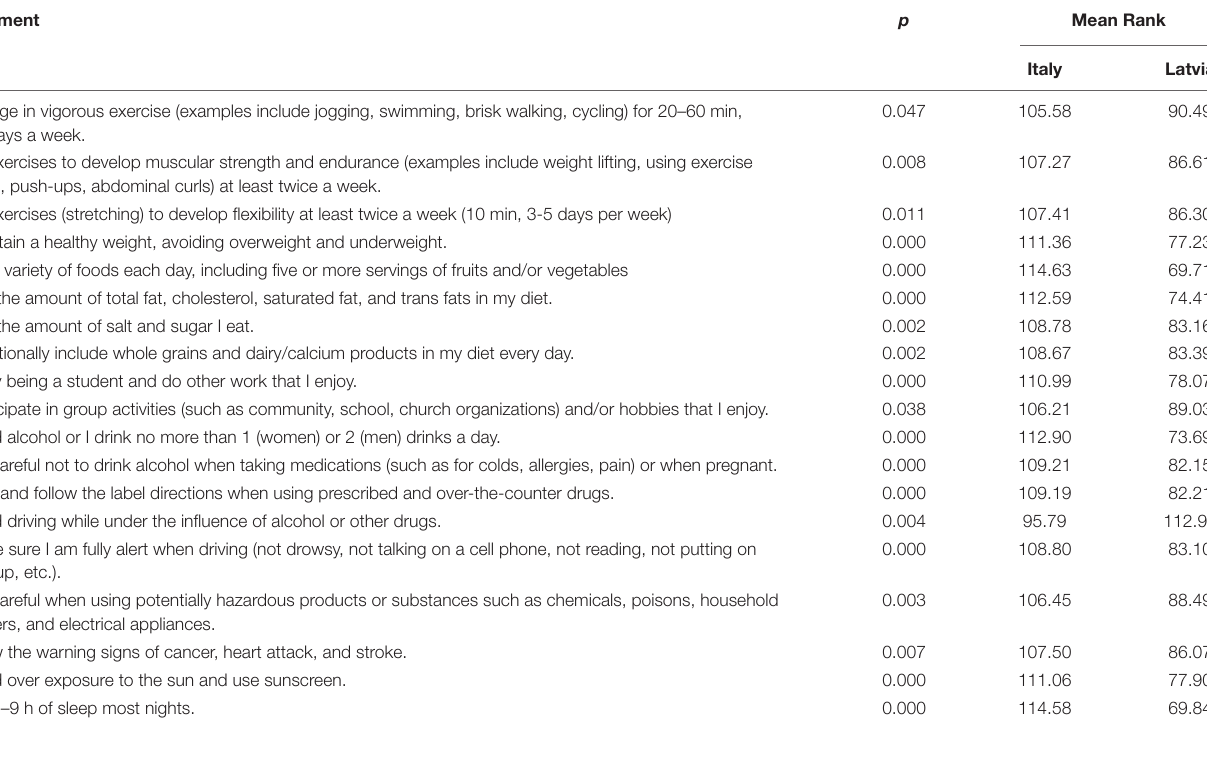
TABLE 6 | Overall healthy lifestyle differences between Latvian and Italian sports